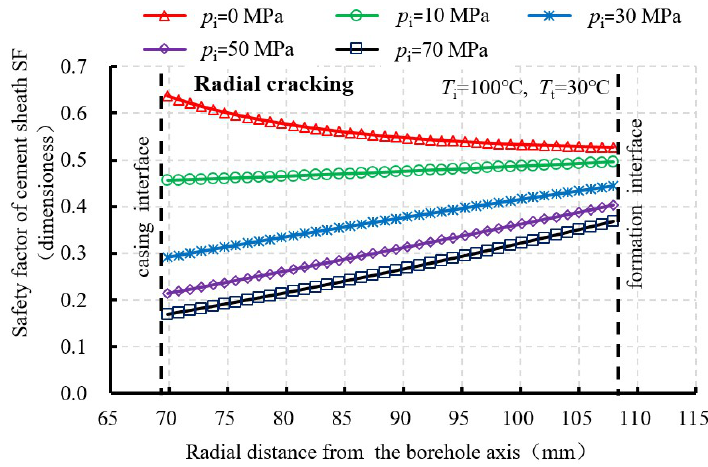
Figure 8. Radial distribution of the cement sheath safety factors for radial cracking under different increased casing pressures p i and decreased temperature of 70 °C at the casing inner wall.